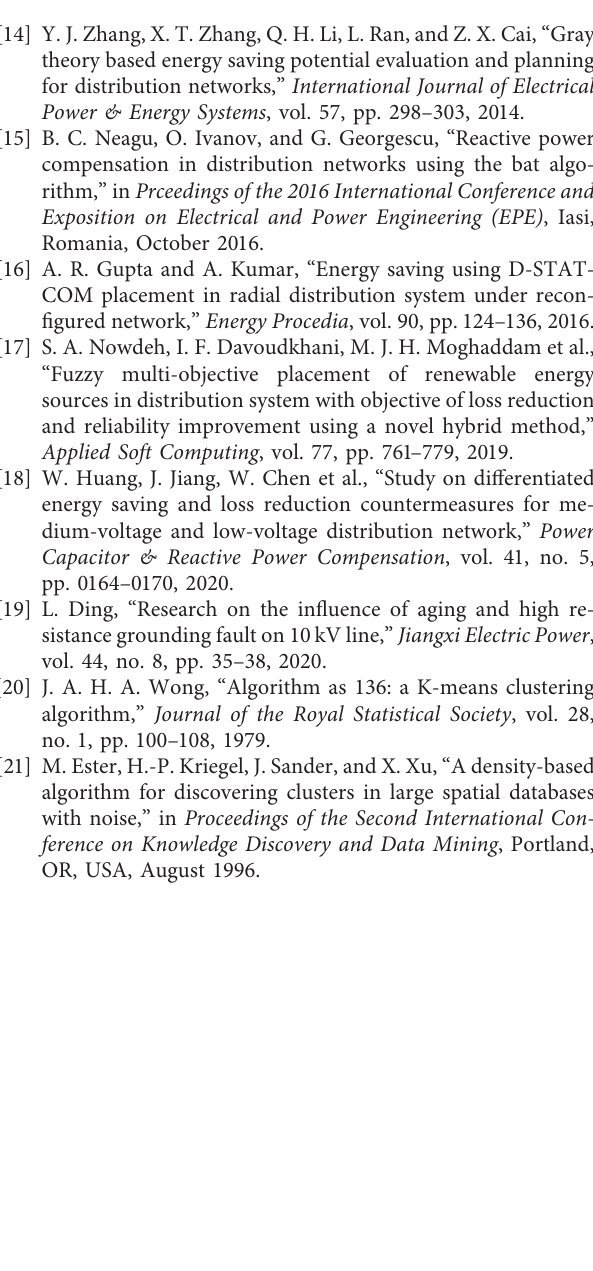
Table S1: line types. Table S2: transformer types. Table S3: branch information of the 10 kV feeder in the actual dis- tribution network. ( Supplementary Materials